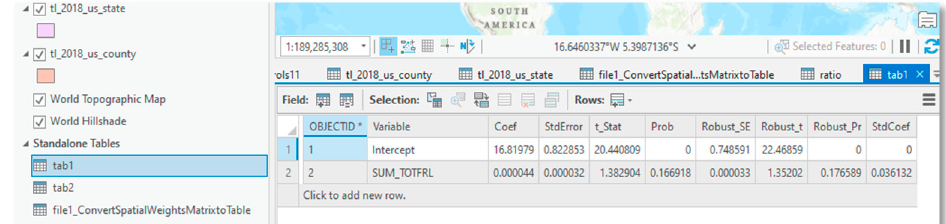
Figure 7. Model result parameter table example.